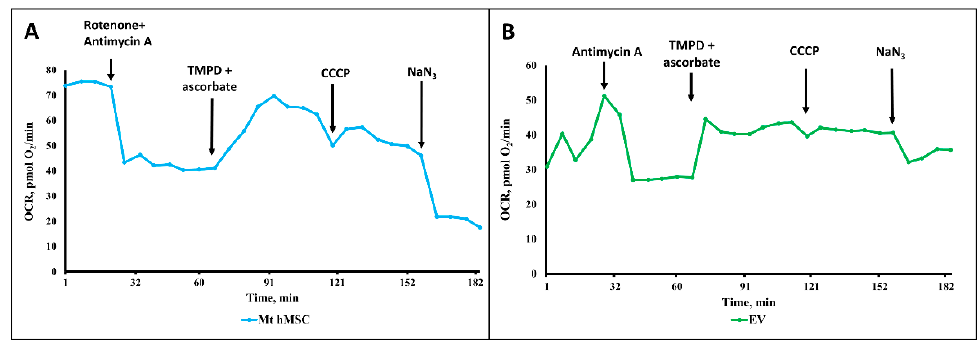
Figure 10. Oxygen consumption rate (OCR) of mitochondria isolated from MSC (( A ), Mt hMSC, blue trace) and ectosomes (( B ), EV, green trace). In ( A ), the medium contained pyruvate (10 mM), malate (2 mM), NADH (1 mM), cytochrome C (5 μ M). In ( B ), the medium contained succinate (10 mM), rotenone (3 μ M). Additions in ports: rotenone (3 μ M), antimycin A (4 μ M), TMPD (150 μ M), ascorbate (10 mM), CCCP (1 μ M), NaN 3 (5 mM).